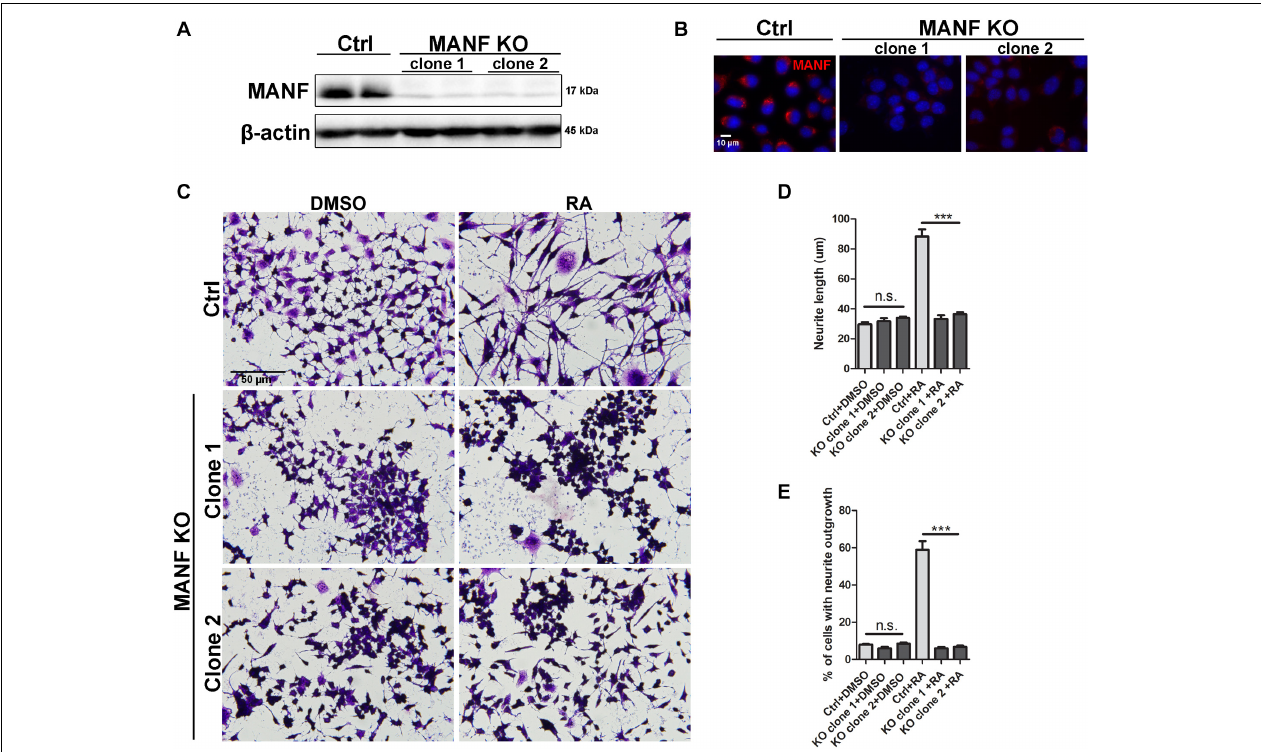
FIGURE 1 | Loss of MANF inhibits RA-induced neurite outgrowth. Stable N2a cell lines of MANF knockout (KO) were established as described in the Materials and Methods. (A) Protein was collected from control and MANF KO cell lysates and analyzed by immunoblotting with MANF antibody. β -actin was used as a loading control. The size of the proteins (kDa) was labeled next to each band. (B) Immunofluorescent staining showed MANF expression in control cells and no signal in MANF KO cells. Cell nuclei were stained by DAPI. (C) Representative images of control and MANF KO cells treated with DMSO or RA for 3 days. Cells were fixed and stained with crystal violet for visualization. Average neurite length (D) and percentage of cells that bear neurites (E) were measured, and analyzed by One-way ANOVA. In cases where significant differences were detected, specific post hoc comparisons between treatment groups were examined with the Tukey’s test. *** P < 0.0001, n.s. not statistically significant. The data were expressed as the mean ± SEM of three independent